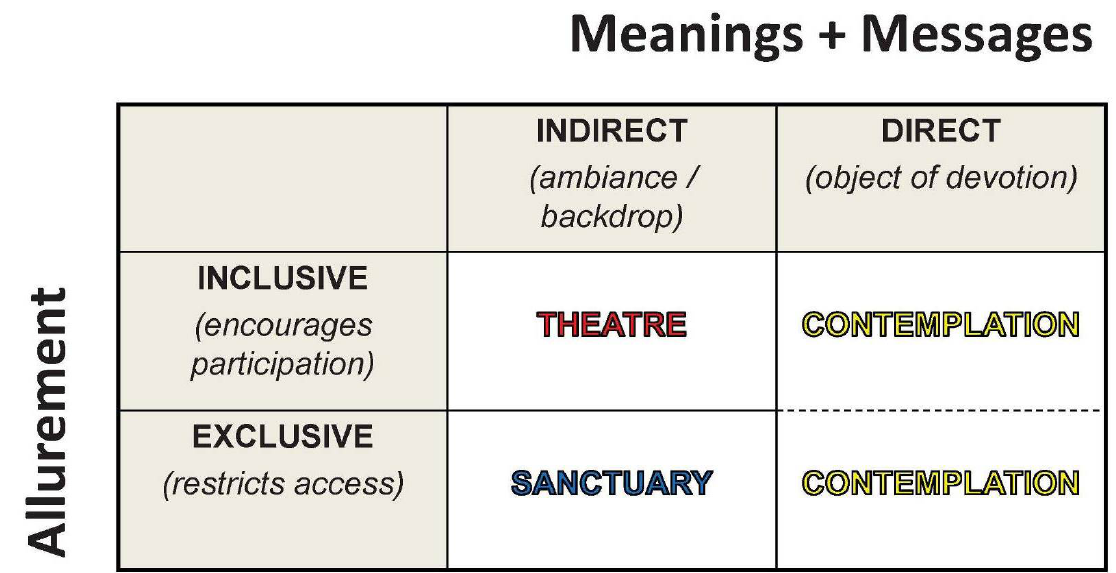
Figure 2. Graphical overview of Lindsay Jones’ three main ritual contexts by the author. The diagram illustrates the level of allurement (e.g., inclusive versus exclusive) that is associated with each ritual context and the types of indirect or direct messages that are conveyed to people through the architecture.